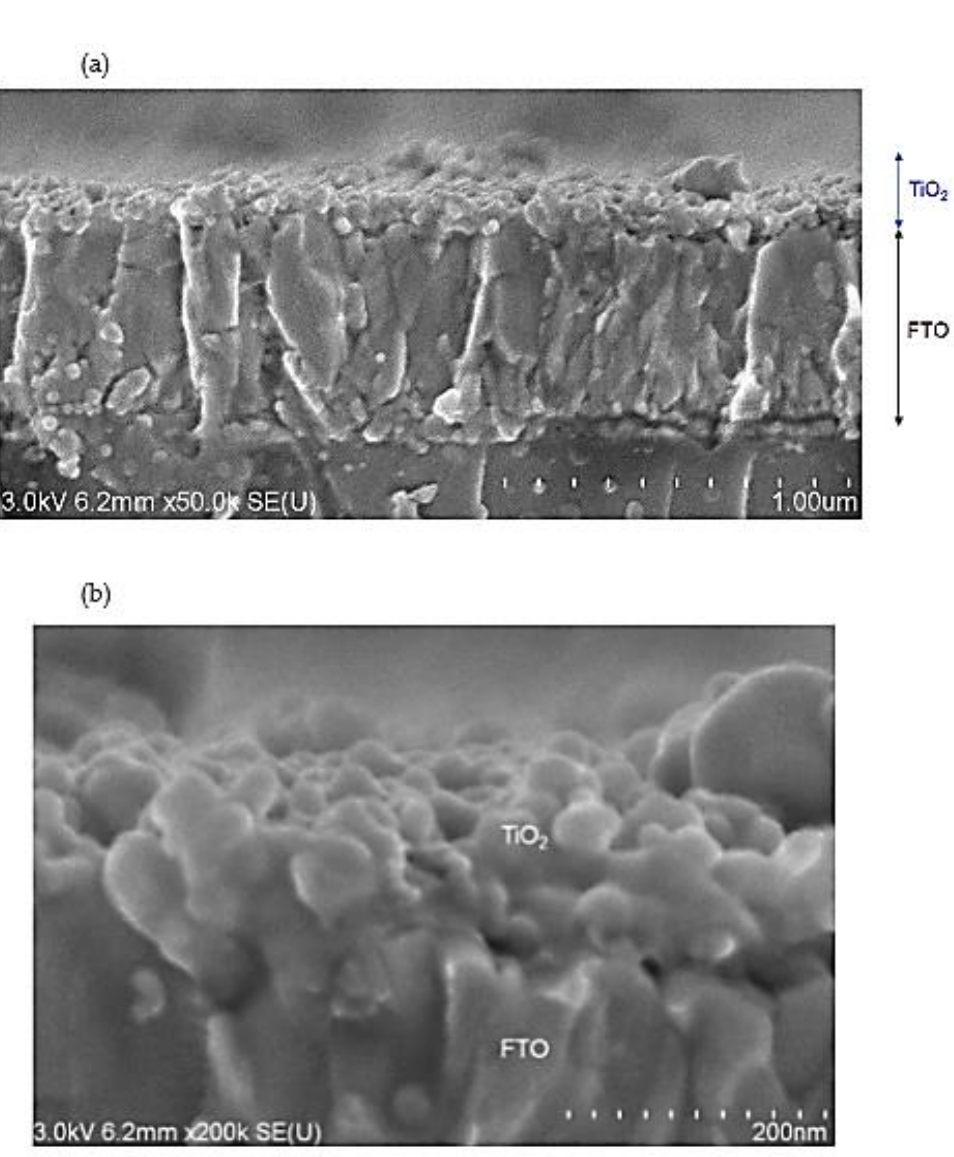
Figure 6. ( a , b ) Cross-sectional SEM images of an as-deposited TiO 2 film after nanofluid pool boiling. ( b ) High-magnification image of the same sample. The iph and I correspond to the integral current density and intensity of incident light (I = 1000 W/m 2 ), respectively. The preliminary test of the TiO 2 /SnO 2 substrate deposited using pool boiling in Table 1 showed a relatively low efficiency of 6.63% (Device 2), when compared to that of the control experiment using the conventional spin-coat method (Device 1). The decreased efficiency is probably due to the uneven surface of the TiO 2 /SnO 2 layer as presented in Figure 6, leading to the imperfect connection between the ETL and crystallized perovskite after its perovskite spin-coat process. In fact, an additional compact TiO 2 layer (one-time coat-process of TiO 2 ) formed on top of both pure TiO 2 (Device 3) and TiO 2 /SnO 2 (Device 4) ETLs had a tendency to improve the light-to-electricity conversion efficiency. Optimization of the lateral structure at a nanoscale using nanofluid pool boiling will provide useful criteria for ETL to further improve the solar cells’ performance without the loss of costly materials such as nanocrystalline-TiO 2